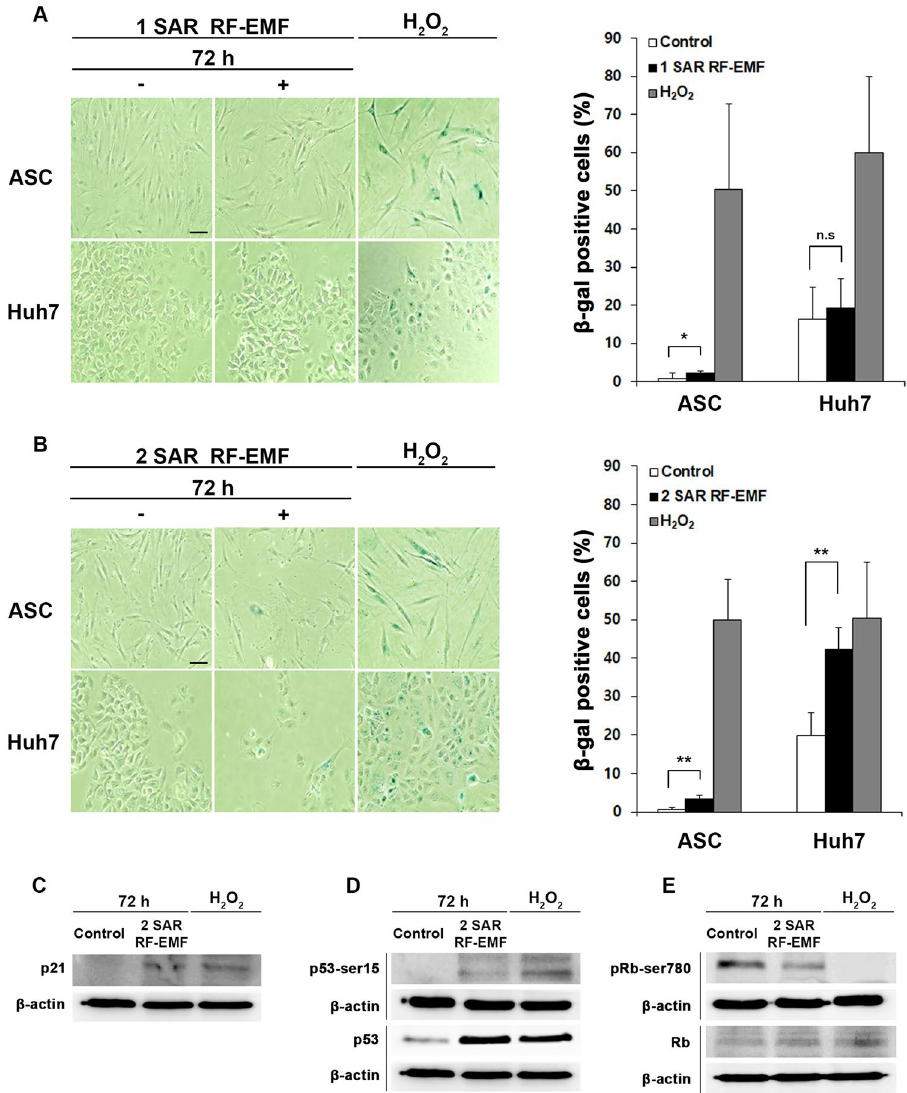
Figure 6. Continuous exposure to 1.7 GHz LTE RF-EMF induced cellular senescence in ASCs and Huh7 cells. ( A,B ) ASCs and Huh7 cells exposed to 1.7 GHz LTE RF-EMF for 72 h at 1 SAR (A) or 2 SAR ( B ). Cells were fixed in 2% formaldehyde and 0.2% glutaraldehyde, and incubated with 0.1% X-gal for 30 h. ASCs treated with 200 μ M H 2 O 2 for 1 h and Huh7 cells treated with 300 μ M H 2 O 2 for 2 h were respectively used as a positive control. Images were taken with a Nikon microscope (ECLIPSE Ts2) under a 10 × objective. Scale bar, 50 μ m. A total 200 cells were counted for each experiment. The percentages are SA- β -gal positive cells over total cells counted. The experiment was performed in triplicate and the cell percentage was plotted as mean ± S.D. P < 0.05 ( * ), P < 0.01( ** ) and P > 0.05 (non-significant, n.s.). ( C–E ) 1.7 GHz LTE RF-EMF exposed Huh7 cells ( B ) were subjected to western blots with ( C ) anti-p21, ( D ) anti-phosphorated-p53 at Ser15 and anti-p53, ( E ) anti-Rb and anti-phosphorylated-Rb at Ser 780. β -actin from the same blot was used as a loading